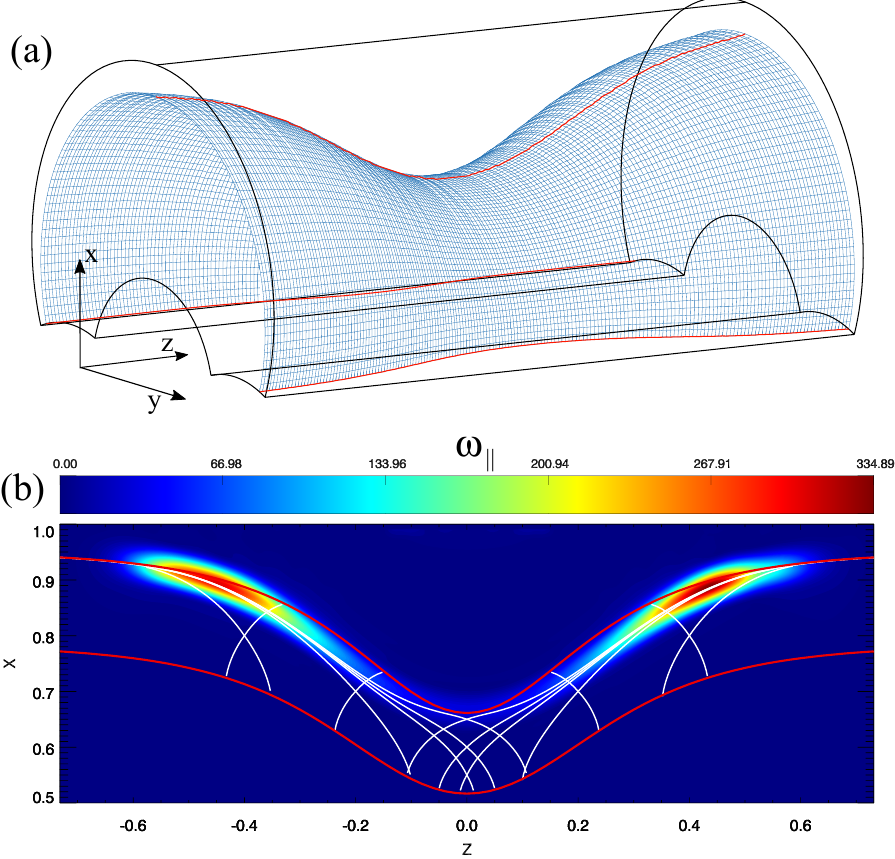
Figure 4. ( a ) The surface containing the resonant Alfvén waves (identified from Figure 3b as a maximum of the time-averaged energy density). ( b ) A cut in the vertical y = 0 plane of the magnitude of the field-aligned vorticity. Overplotted is the Resonance Map showing permissible Resonant Paths (white lines) and the boundaries of the Resonant Zone (red lines). See text for